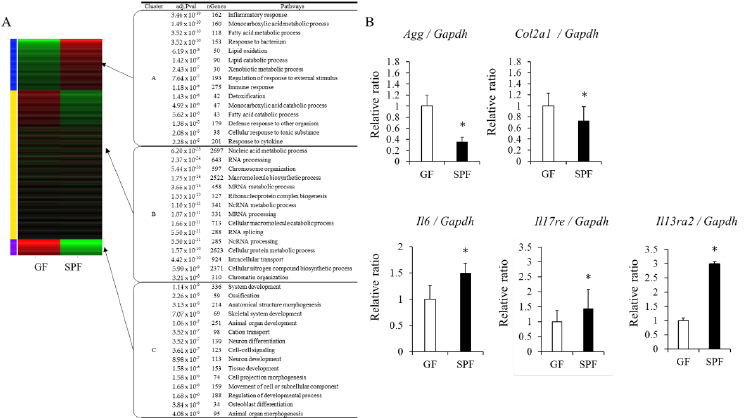
Figure 4. Maternal gut microbiome affects gene expression in chondrocytes of the fetus. ( A ) K- means clustering and enrichment analysis, ( B ) gene expression analysis in primary chondrocytes from GF and SPF rib cages. The data are presented as the mean ± SD ( n = 3, t -test, * p <